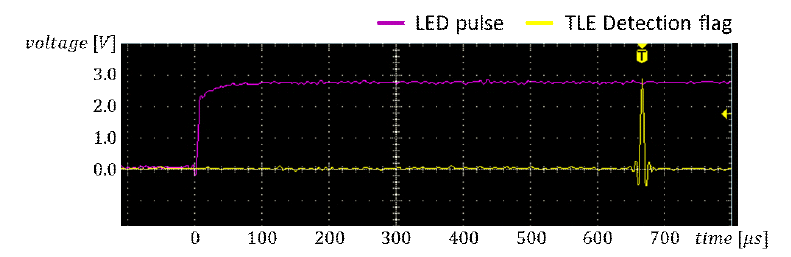
Figure 15. Latency between the UV LED pulse and the TLE detection flag. The latency was 664 µ s which is caused by the TLE detection